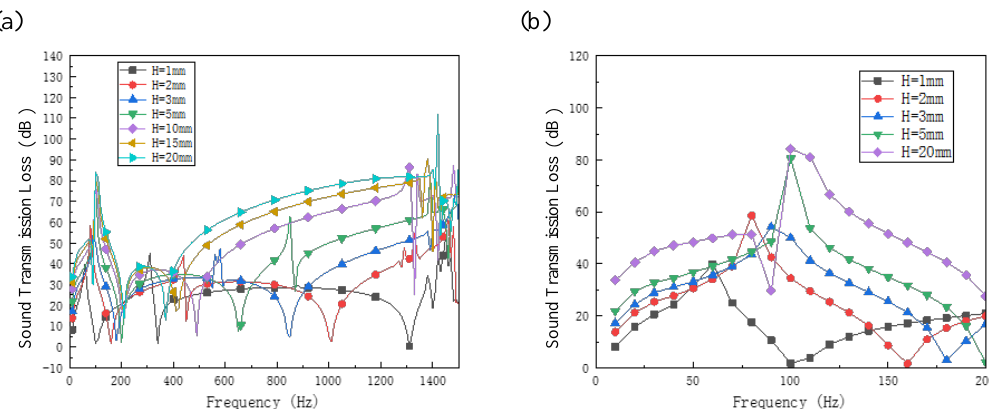
Figure 14. Effect of plate thickness on STL for cavity thickness of 1 mm: ( a ) 0 – 1500 Hz and ( b ) 0 – 200 Hz.